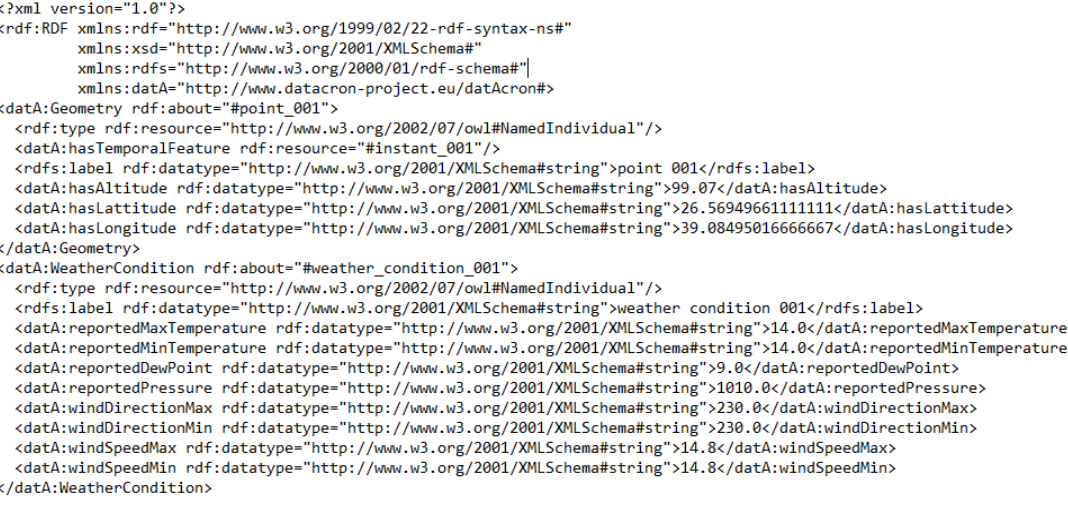
Figure 15. A point in the evaluated trajectory, along with weather data, in RDF.